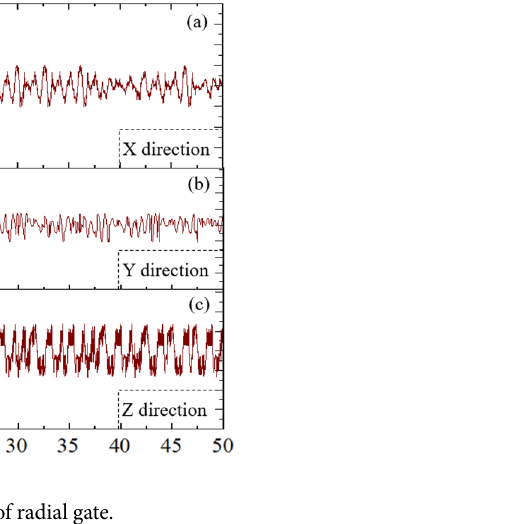
Figure 9. Flow-induced deformation of radial